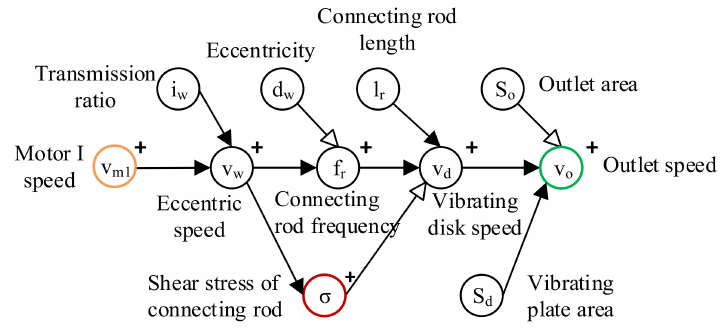
Figure 19. The physical parameter change path of “TCM accumulation at outlet”.